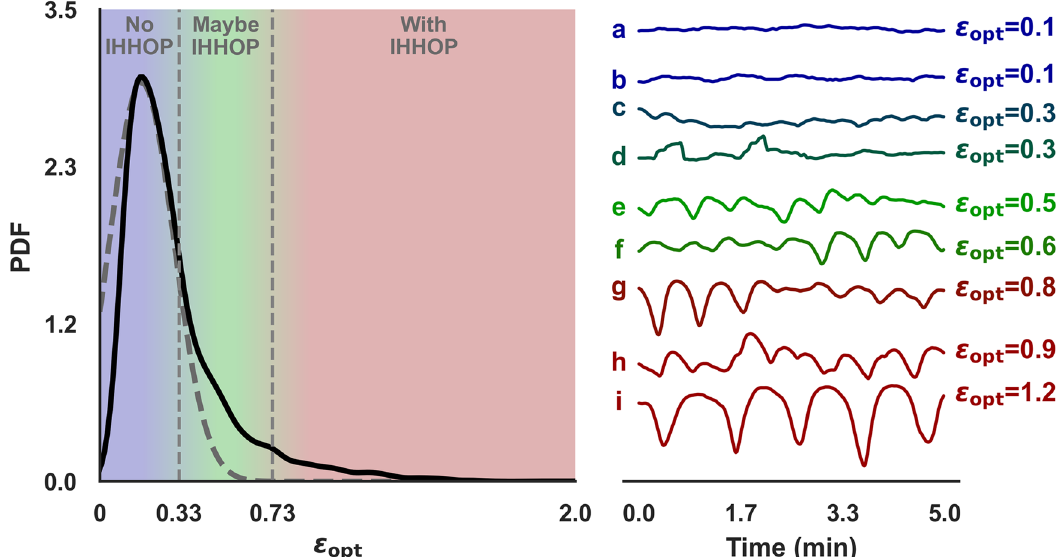
Figure 2. Distribution of values of ǫ opt calculated from 5 min segments of SaO 2 with 1.0 Hz sampling frequency, with a rolling window step size of 1 min, the vertically defined regions mark the clustering of the segments in three categories: no IHHOP (light blue), maybe IHHOP (light green) and with IHHOP (light red). On the right side, there are illustrative oxygen saturation 5-min segments for different values of ǫ opt . The y-axis is omitted to emphasize relative differences between the segments, all have the same scale for oxygen saturation